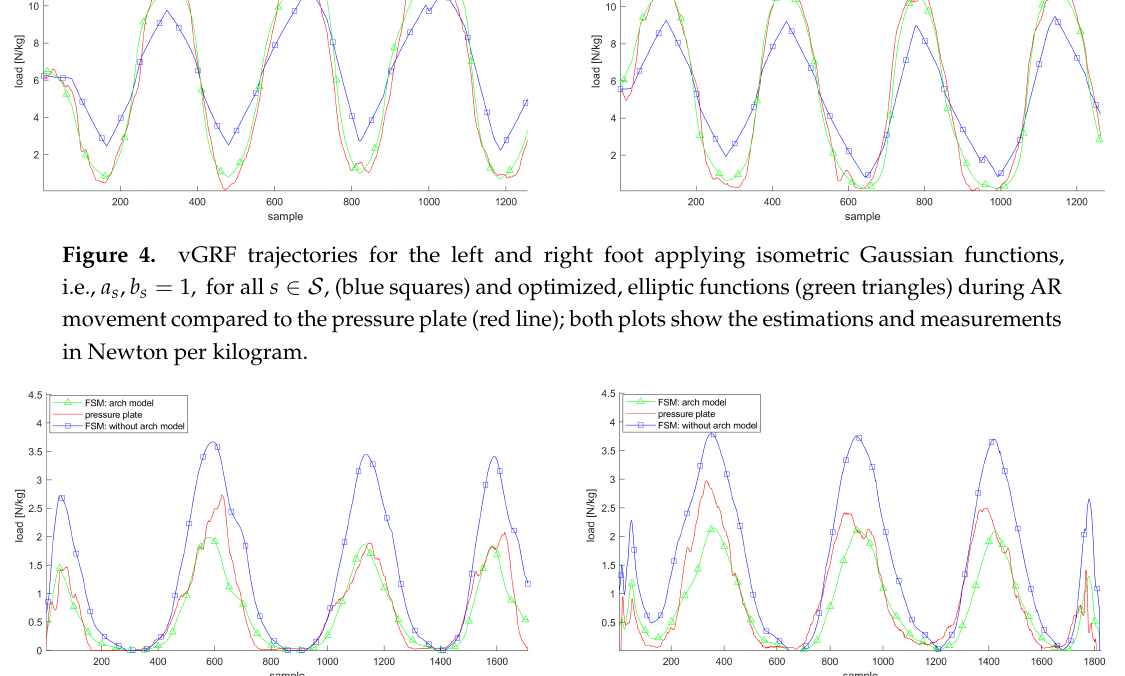
Figure 5. vGRF Arch trajectories for the left and right foot before (blue squares) and after (green triangles) modeling the foot arch during AR movement (left) compared to the pressure plate (red line); both plots show the estimations and measurements in Newton per kilogram.